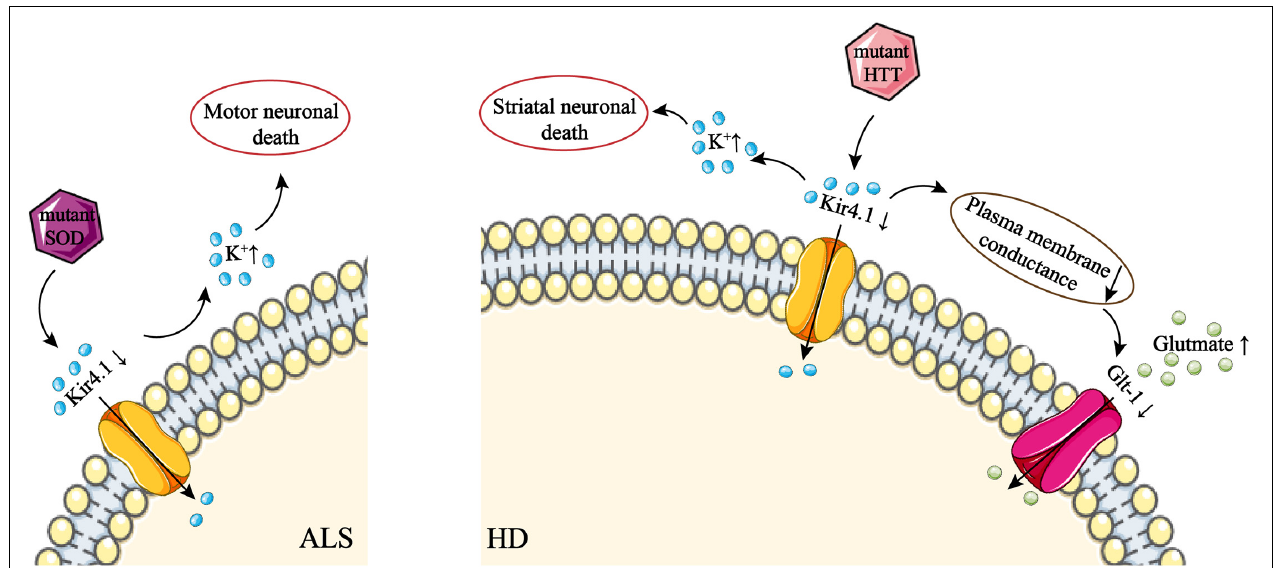
FIGURE 3 | The role of Kir4.1 channel deficiency in ALS and HD. Downregulation of Kir4.1 by mutant SOD disrupts K + influx, which leads to an excessive extracellular K + concentration. This disrupts the extracellular environment of neurons and subsequently causes motor neuron death. In addition, mislocalization and overexpression of AQP4 channels on astrocytes can lead to astrocyte swelling. This may downregulate AQP4 due to the sensitivity of AQP4 to stretch, although this mechanism is uncertain. Downregulation of Kir4.1 by mutant HTT disrupts K + influx, which leads to an excessive extracellular K + concentration. This disrupts the extracellular environment of neurons and subsequently causes striatal neuron death. High conductance of the plasma membrane via Kir4.1 can activate Glt-1, which takes part in the uptake of glutamate by astrocytes. However, downregulation of Kir4.1 leads to a decrease in plasma membrane conductance, which disrupts glutamate uptake by astrocytes. ALS, amyotrophic lateral sclerosis; AQP, aquaporin; Glt-1, glial glutamate transporter 1; HD, Huntington’s disease; HTT, huntingtin; SOD, superoxide